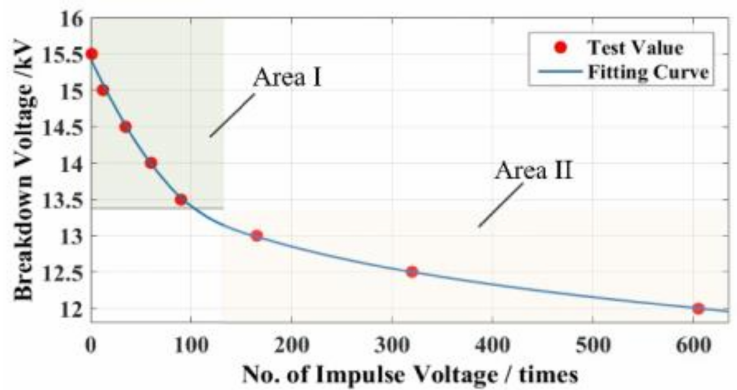
Figure 1. The U-N characteristics of an oil-film dielectric